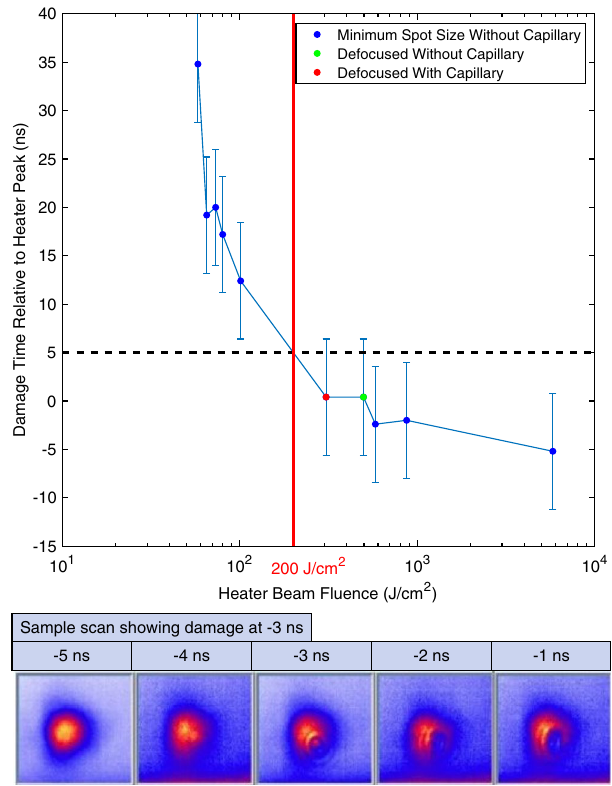
FIG. 3. Time at which damage occurred vs the heater laser fluence at the surface of the LC film. The blue points are for data collected with a focused heater beam incident on the film without a capillary present. The green point shows data collected at higher energy with a defocused heater. The Red point is a scan done with the heater and capillary discharge both active with the film 6 cm from the capillary exit. A representative scan is provided to show the distortions that appear when the film is damaged. The error bar represents the range of measured heater delays for a set of shots where the delay was known to be